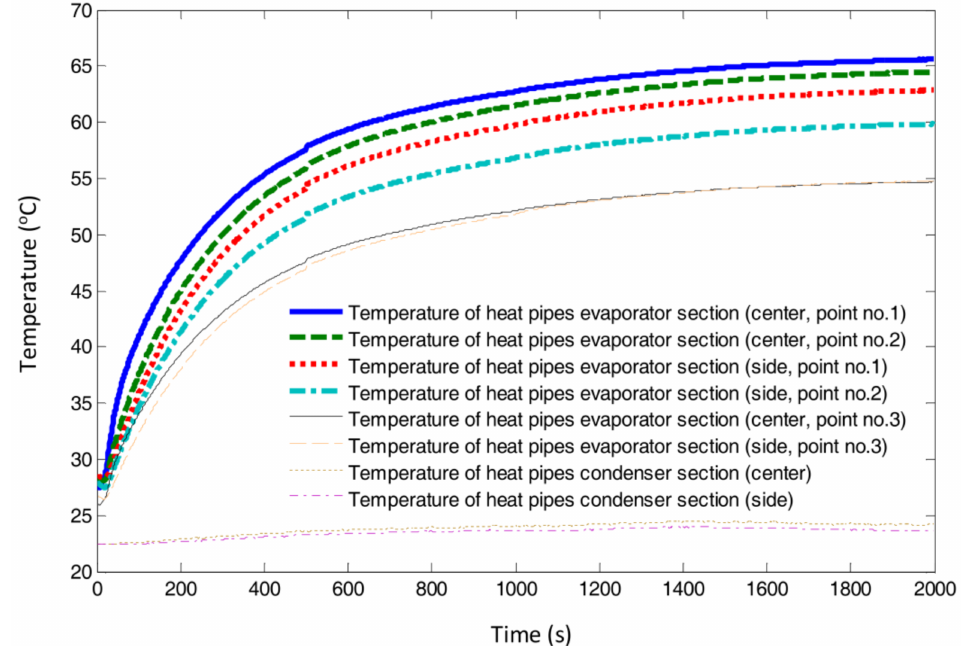
Figure 4. Temperature as a function of time in the evaporator and the condenser section of the heat pipes (diameter of 6 mm, effective length of 190 mm pressed thickness of 2 mm and width of 8.50 mm at the evaporator section) in different locations (against gravity orientation). The error of 1% was associated with the results using the heat supply rate of 39